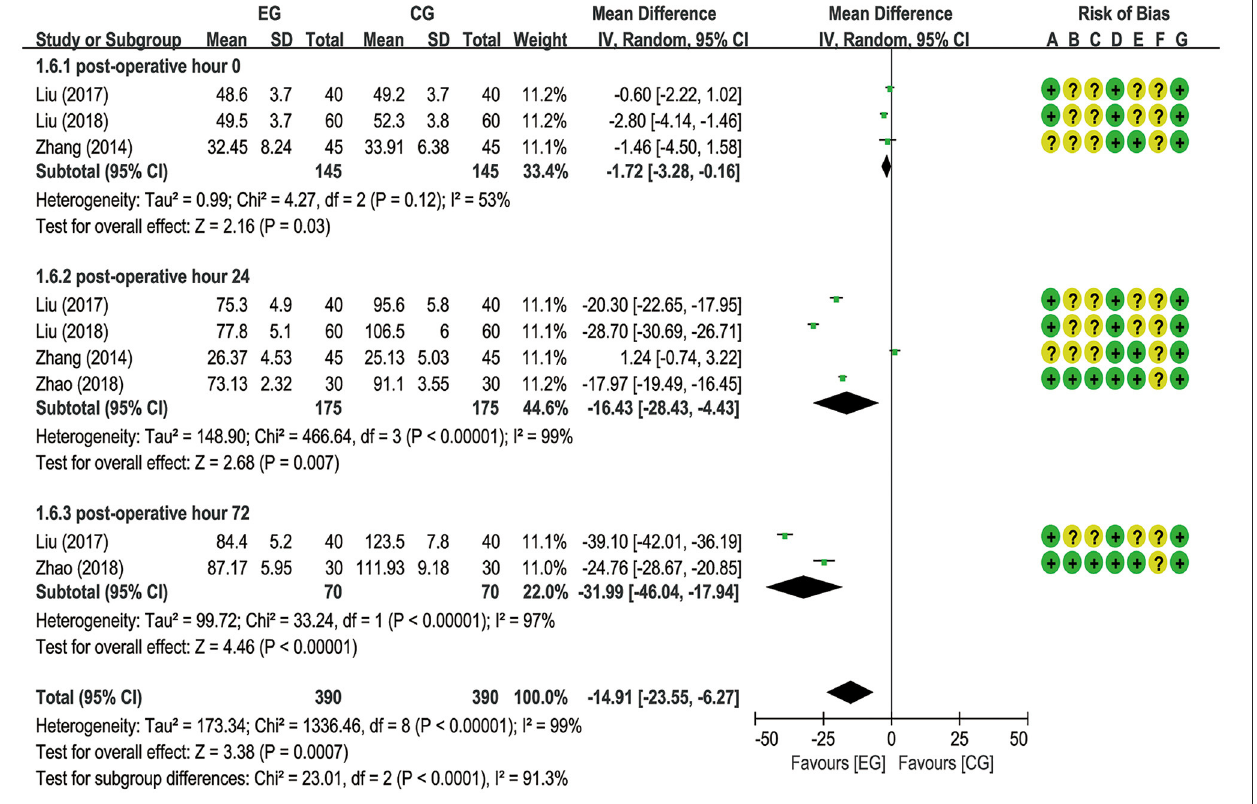
FIGURE 7 | Meta-analysis and forest plot and for interleukin-1 β (IL-1 β ) at different